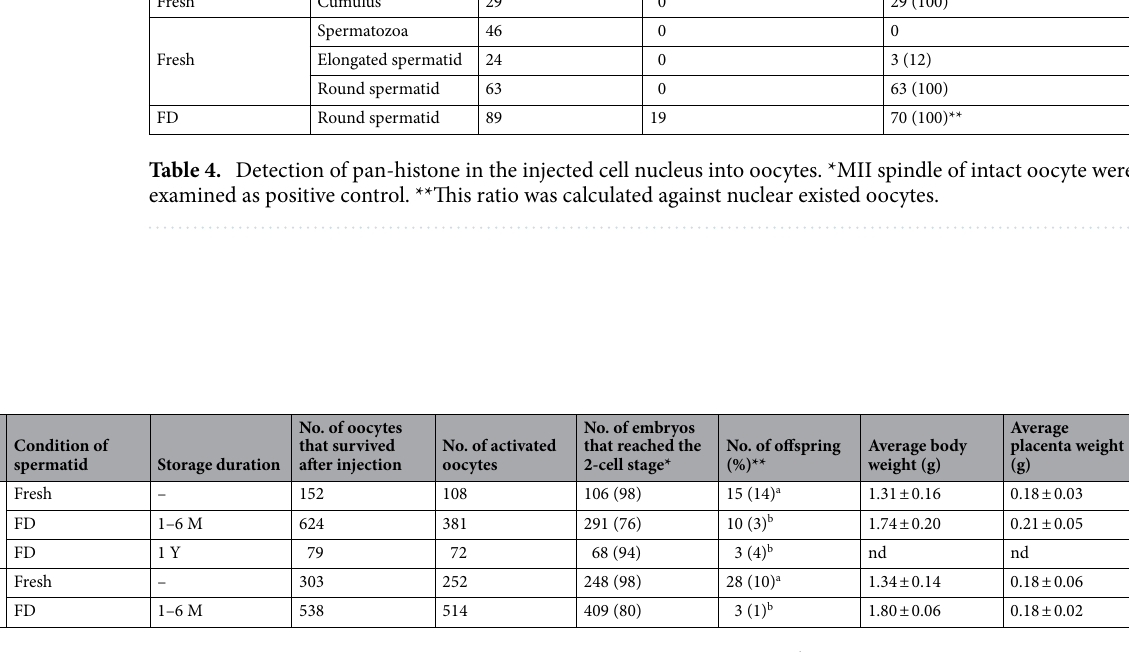
Table 5. Production of offspring from freeze-dried spermatids. a versus b P < 0.05. *All embryos were transferred into oviduct of recipient female. **% from transferred 2-cell